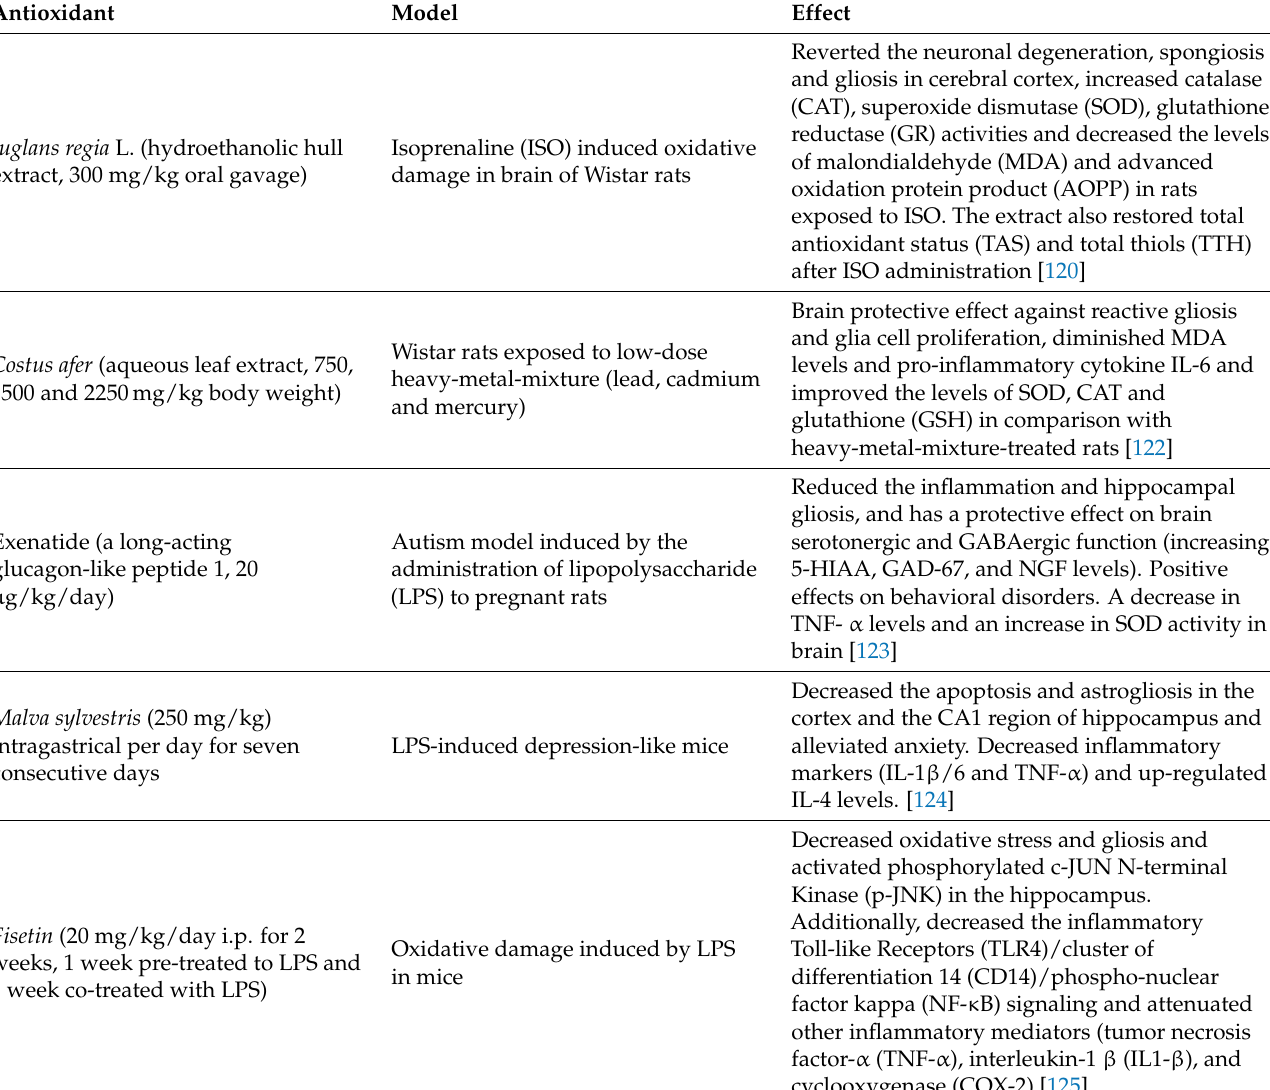
Table 1. Potential antioxidants for gliosis treatment in obese